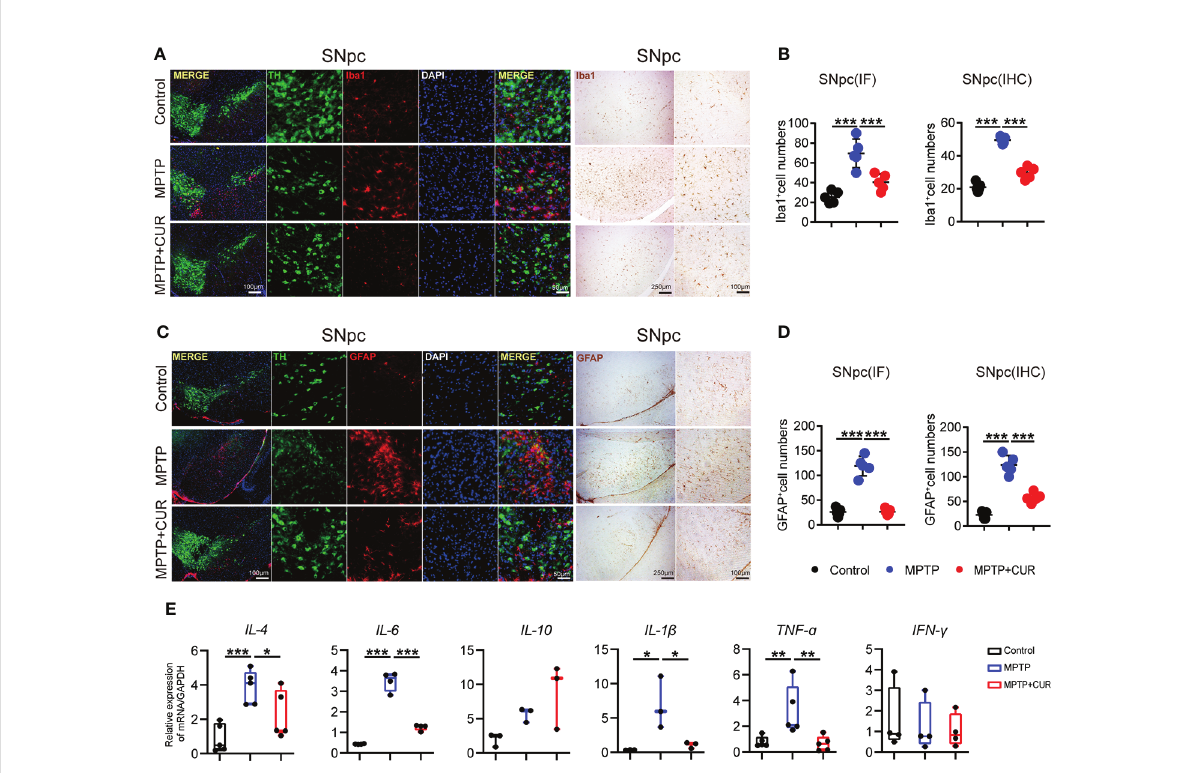
FIGURE 2 CUR administration suppresses glial cells activation in SNpc in MPTP-induced mice model. Male C57BL/6 mice were received intragastric administration of CUR (100 mg/kg) once a day for 4 weeks. On day 15, mice were treated with 200 m L saline containing MPTP (30 mg/kg) or 200 m L saline via intraperitoneal injection every day for a total of 5 times to establish PD mice model. On day 28, the mice were sacri fi ced to determine the reactive glial cells of PD by immunohistochemistry and immuno fl uorescence. (A) Representative immuno fl uorescence images of nuclei (DAPI, blue), dopaminergic neurons (TH, green), and microglia (Iba1, red) in the SNpc among MPTP treated mice, CUR treated mice and controls. (B) Quanti fi cation of Iba1 positive cells in the SNpc using immuno fl uorescence and immunohistochemistry staining among 3 groups (n = 5). (C) Representative immuno fl uorescence staining of nuclei (DAPI, blue), dopaminergic neurons (TH, green), and astrocytes (GFAP, red) in the SNpc among MPTP treated mice, CUR treated mice and controls. (D) Quanti fi cation of GFAP positive cells in the SNpc using immuno fl uorescence and immunohistochemistry staining (n = 5) among 3 groups. (E) The expression of pro-in fl ammatory genes in the striatum among 3 groups (n = 3-6). Data are expressed as mean ± SEM and representative results are one of the independent experiments. All statistical differences were tested using one-way ANOVA in (B, D, E) Quanti fi cation of Iba1-positive cells, GFAP-positive cells was performed by ImageJ. * p < 0.05, ** p < 0.01, *** p <